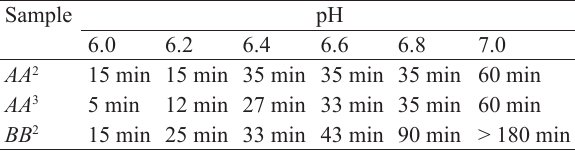
Table 7 Thermal stability of reconstituted dried milk from cows with different CSN3 genotypes by phosphate test Sample